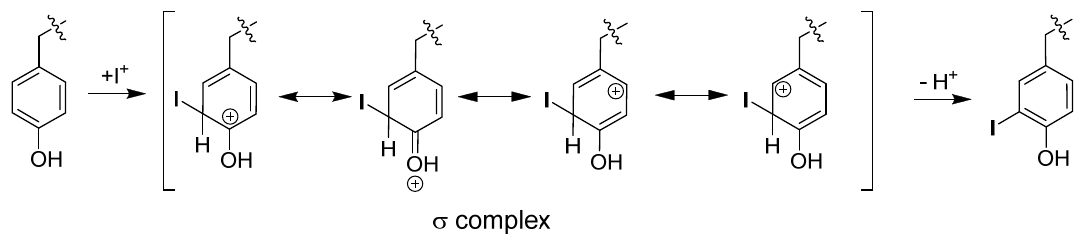
Figure 3. Mechanism of direct electrophilic radioiodination of an iodide electrophile to produce the iodinated